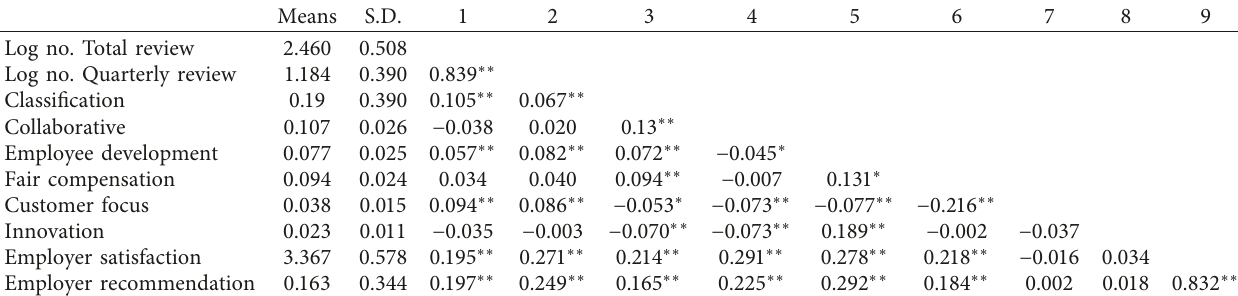
Table 2: Descriptive statistics and correlations ( n � 2 , 116 ) . Note. ∗ p < 0 . 05, ∗∗ p < 0 . 01.